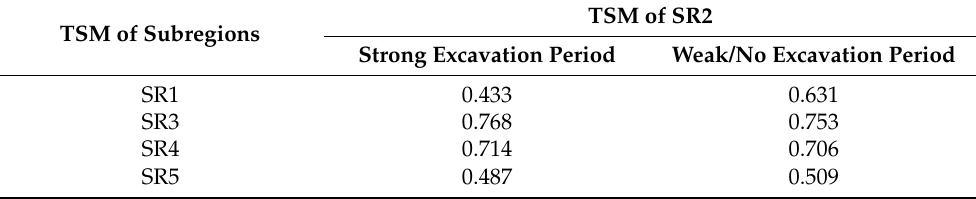
Table 5. The correlation coefficient (R 2 ) of the TSM concentrations between SR2 and other subre- gions during the strong excavation period and the weak/no excavation period. All the correlation coefficients passed the significance test ( p <